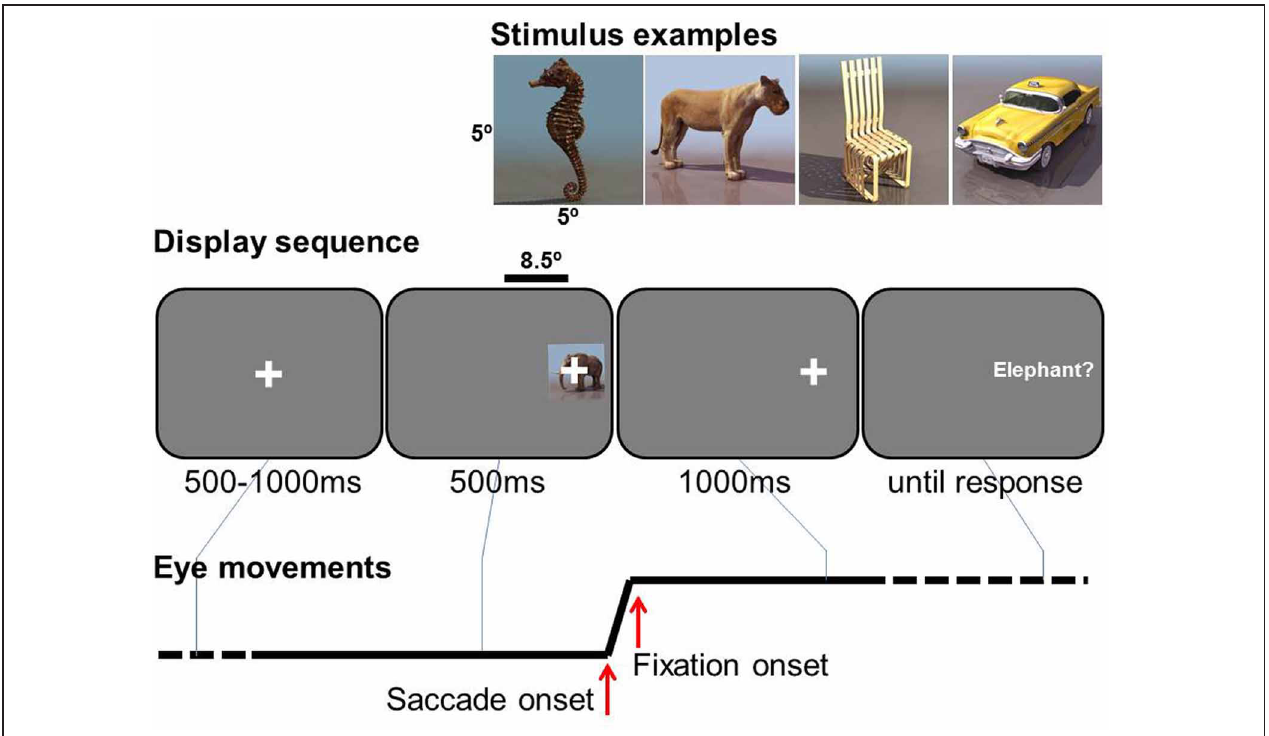
FIGURE 1 | Experimental task. Examples of stimuli (top), a display sequence (middle, not to scale), and an example of horizontal eye movement (bottom).